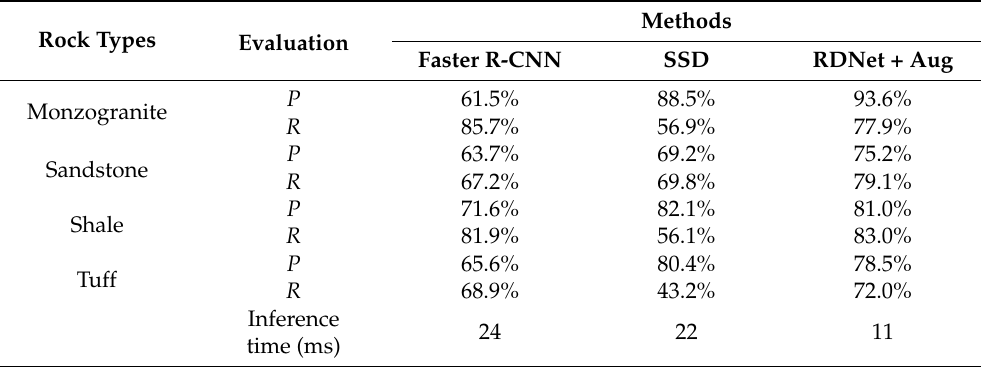
Figure 15. RDNet + Aug and Faster R-CNN evaluation results. ( a ) monzogranite, ( b ) sandstone, ( c ) shale, and ( d ) tuff. Table 10. The best model performance of Faster R-CNN, SSD, and RDNet + Aug on four types rock